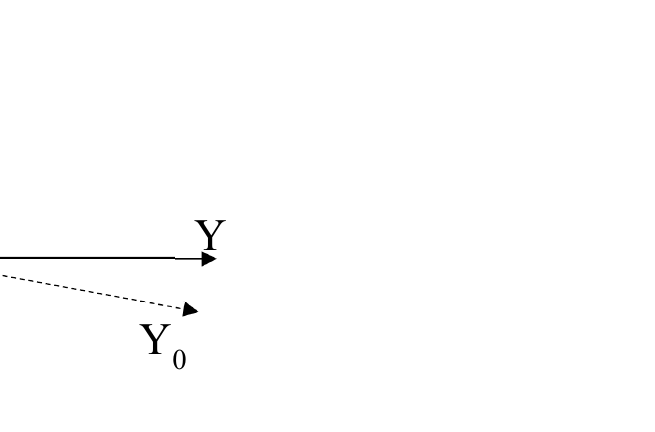
Figure 4. Schematic diagram of coordinate system conversion between attitude and imaging system.